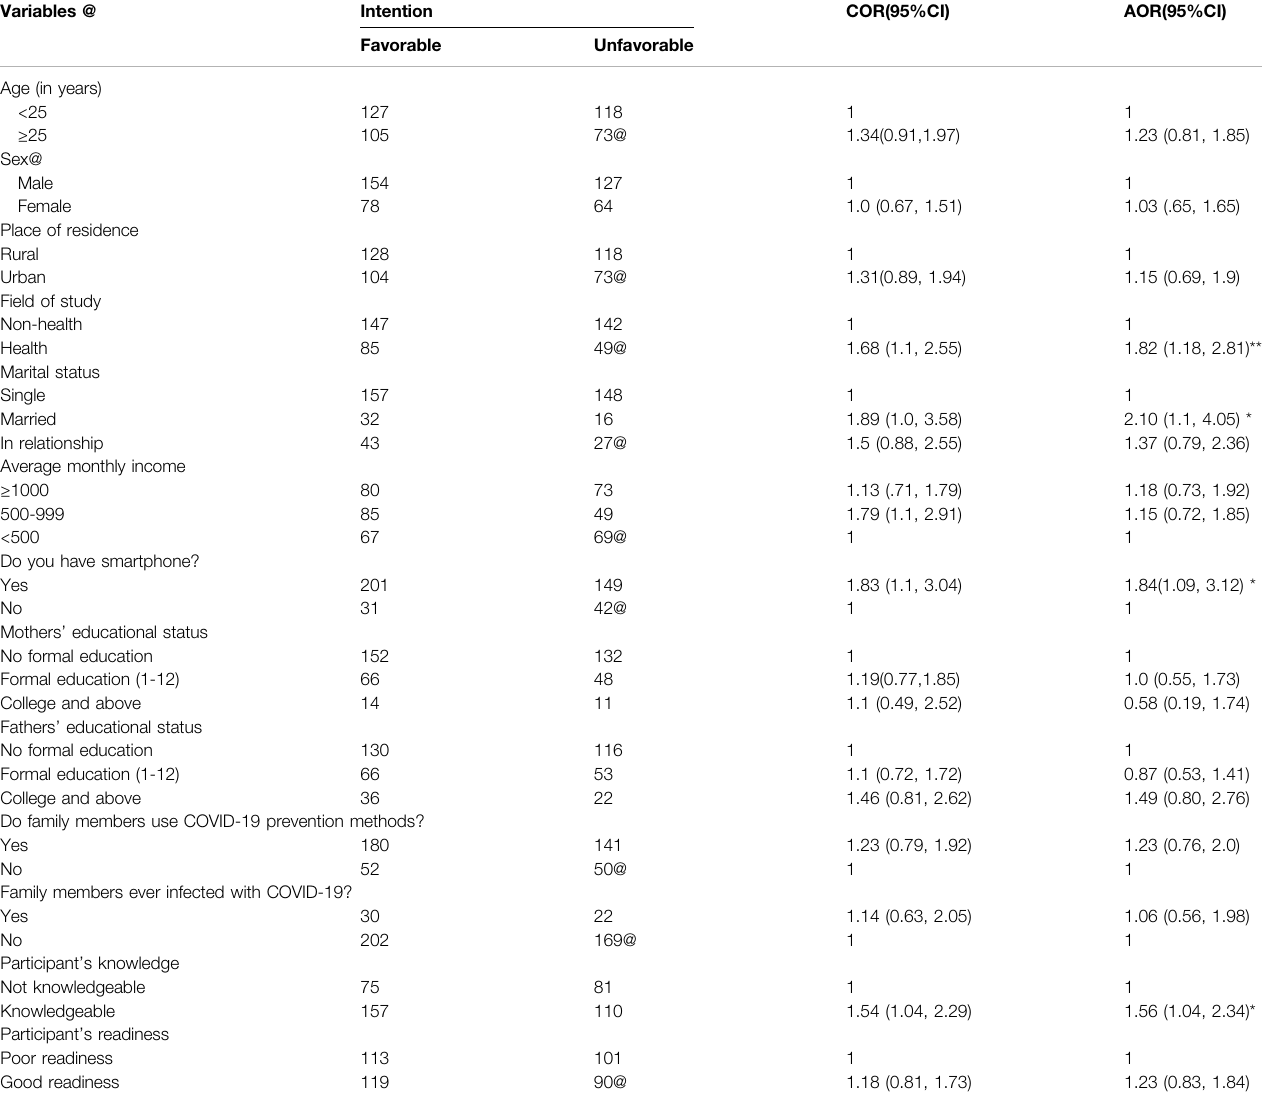
TABLE 5 | Bivariable and multivariable analysis of variables on intention for adapting COVID-19 prevention campaign Debre Berhan University, Northeast Ethiopia, 2021 ( n (cid:1) 423). Variables